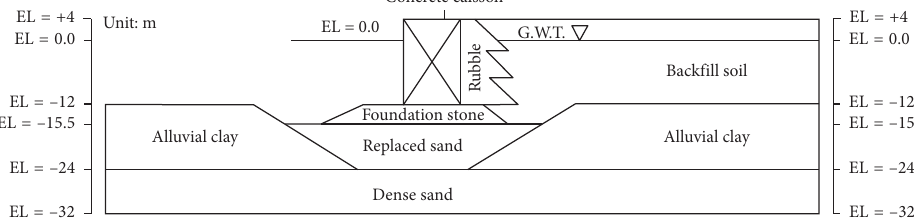
Figure 13: Soil profile developed after Yang [36] for limit equilibrium analysis.